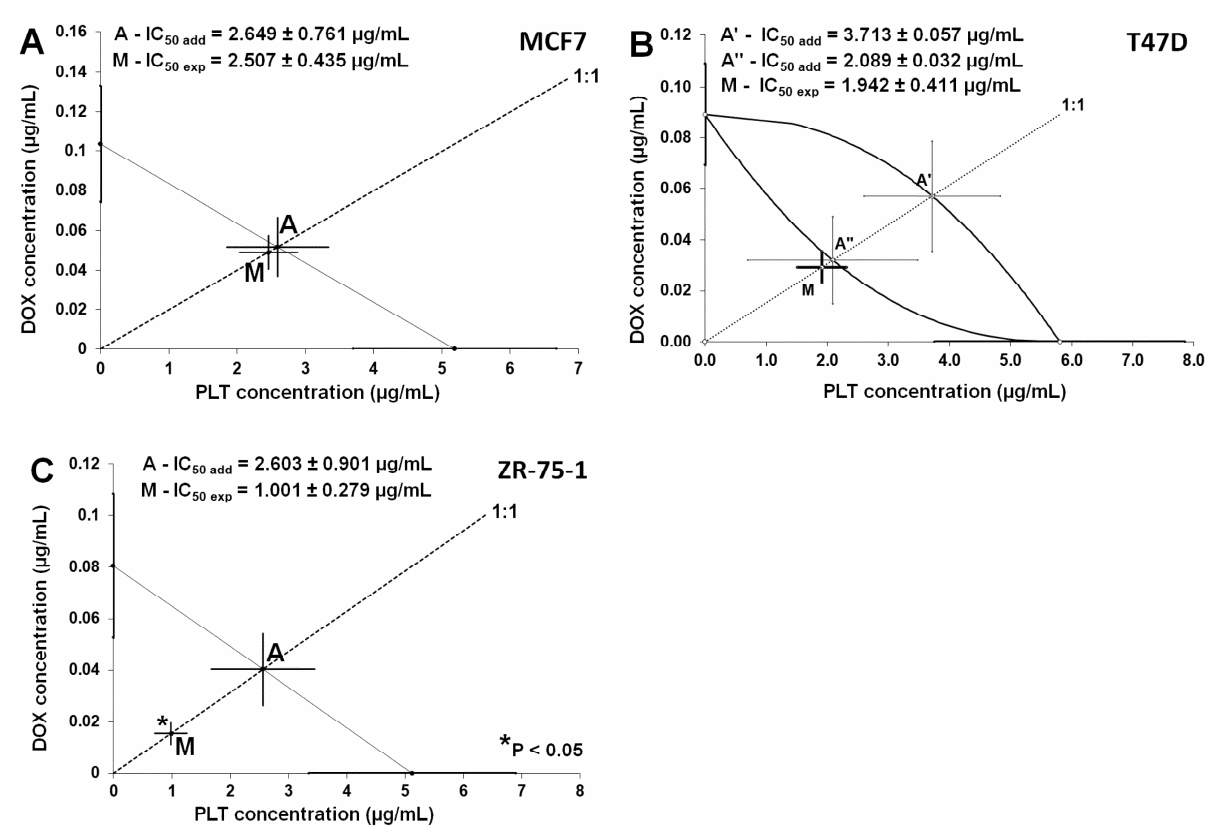
Figure 9. Isobolograms showing additive ( A , B ) and synergistic ( C ) interactions between doxorubicin (DOX) and palmatine (PLT) with respect to their anti-proliferative effects on MCF7 ( A ), T47D ( B ) and ZR-75-1 ( C ) breast cancer cell lines measured in vitro by the MTT assay. The median inhibitory concentrations (IC 50 ) for DOX and PLT are plotted graphically on the x and y axes, respectively. The solid lines on the x and y axes represent the SEM for the IC 50 values of the studied drugs administered alone. The curves connecting the IC 50 values for PLT and DOX administered alone represent the lower and upper isoboles of additivity. The dotted line starting from the point (0,0) corresponds to the fixed-ratio of 1:1 for the combination of DOX with PLT. The diagonal line connects the IC 50 for DOX and PLT on the x and y axes. The points A’ and A” depict the theoretically calculated IC 50add values for both, the lower and upper isoboles of additivity. The experimentallyderived IC 50exp value (point M) for total dose of the mixture expressed as the proportion of DOX and PLT that produced a 50% antiproliferative effect in breast cancer cell lines measured in vitro by the MTT assay. On the graph, the SEM values are presented as horizontal and vertical error bars for every IC 50 value.